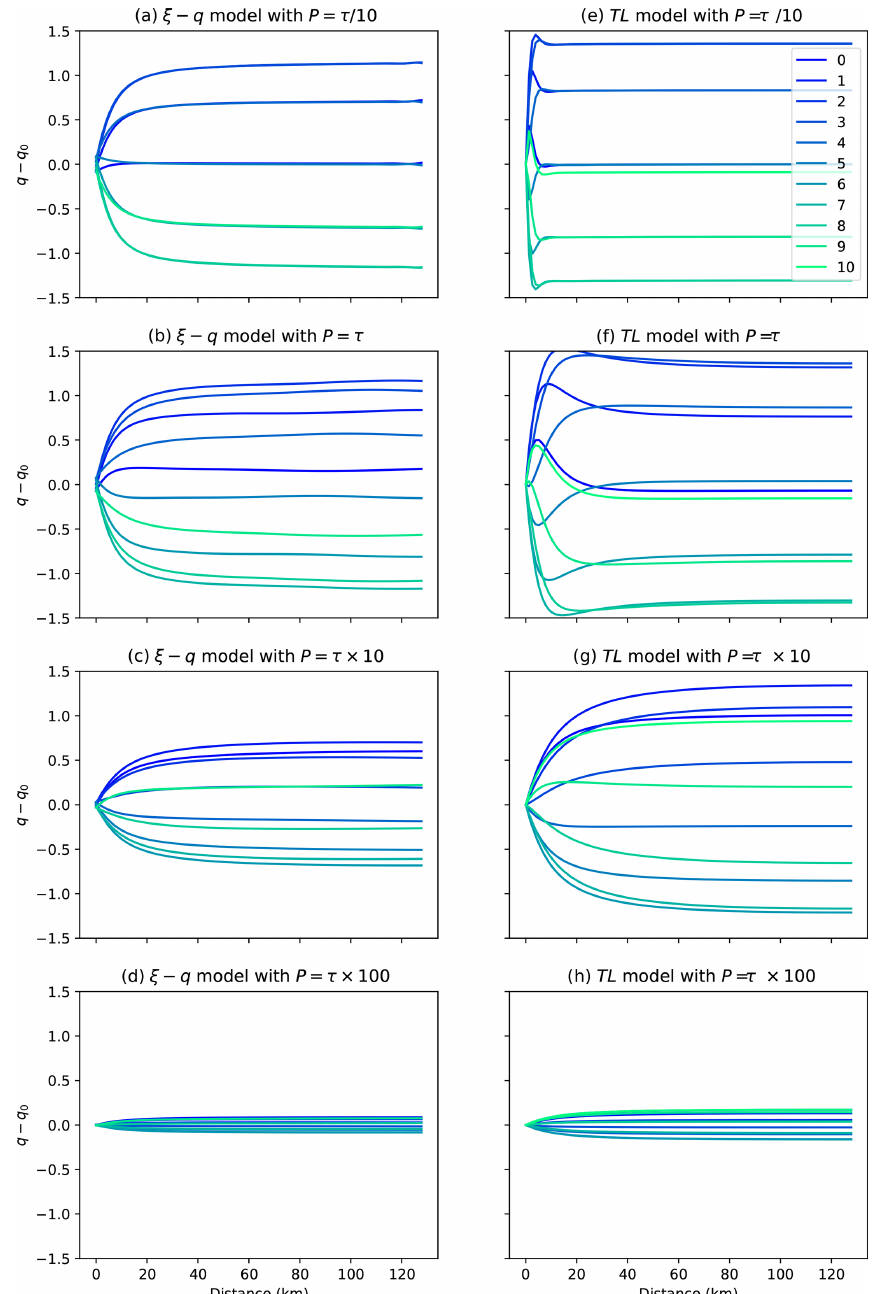
Figure 14. Computed flux profiles across the sedimentary system at 10 time steps within one of the imposed precipitation rate cycle (a– d) using the ξ – q model and (e–h) using the TL model. Going from top to bottom, the forcing period is equal to τ/ 10, τ , 10 τ and 100 × τ , respectively. In all cases shown, L = 10 L 0